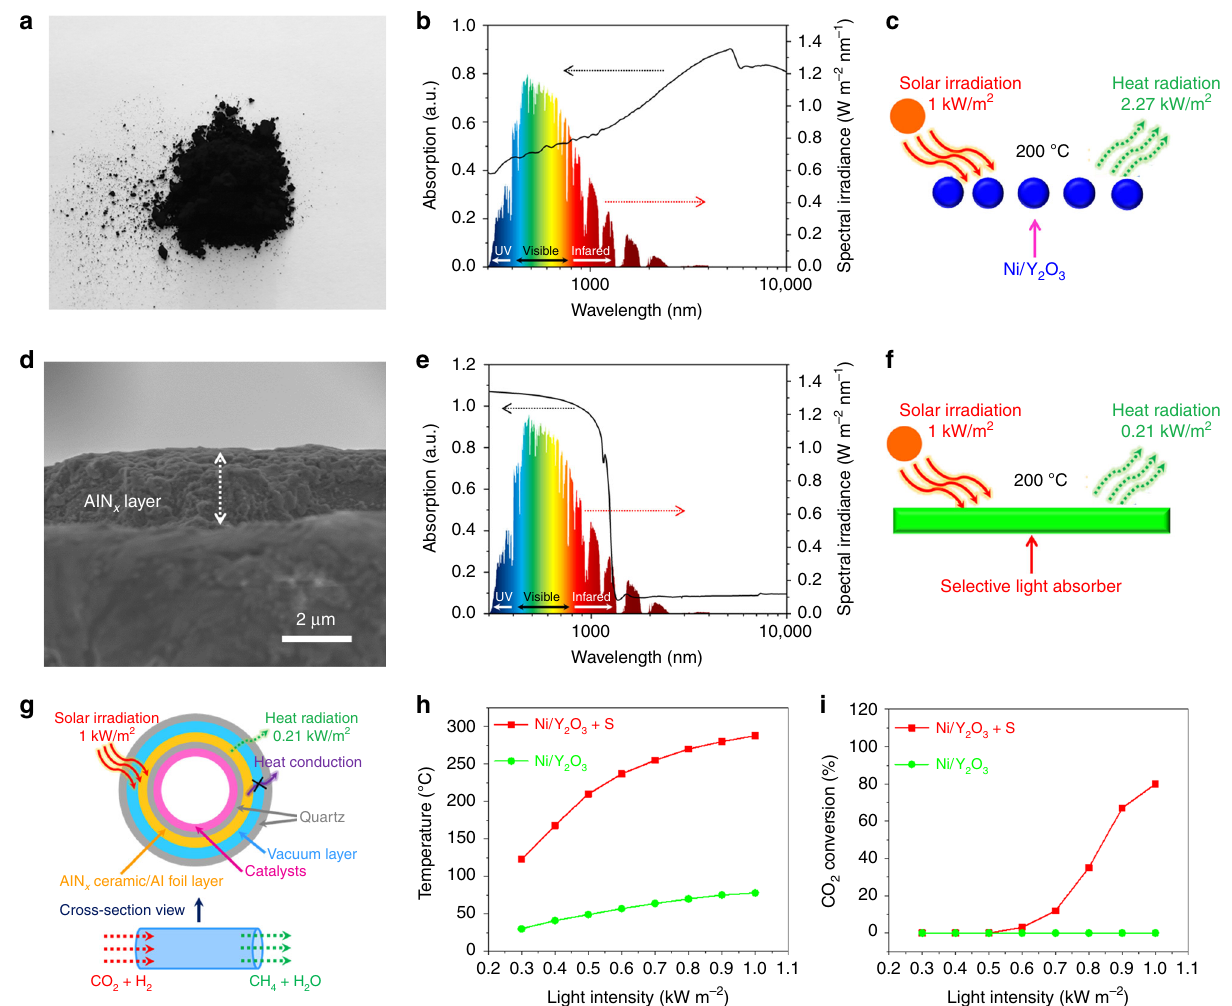
Fig. 1 Traditional and selective light absorber-assisted photothermal systems. a Photograph of the Ni/Y 2 O 3 nanosheets powder. b Normalized UV – Vis – IR absorption spectrum of the Ni/Y 2 O 3 nanosheets. c Solar energy absorption and thermal radiation diagram for the Ni/Y 2 O 3 nanosheets at 200 °C. The ambient solar fl ux of 1 kW m − 2 is not enough to sustain the thermal radiation; thus, an equilibrium temperature of 200 °C cannot be obtained. d Cross- sectional SEM image and e normalized UV – Vis – IR absorption spectrum of the selective light absorber (AlN x /Al foil). f Solar energy absorption and thermal radiation diagram of the selective light absorber at 200 °C. The thermal radiation was far below the absorbed energy from ambient solar fl ux. g Schematic of the new photothermal system used for photothermal CO 2 methanation with the selective absorber and the catalysts. h , i The light-driven temperature and CO 2 conversion rates of the Ni/Y 2 O 3 nanosheets with (Ni/Y 2 O 3 + S red) and without (Ni/Y 2 O 3 green) the selective light absorber-assisted photothermal system, respectively, under different intensities of sunlight irradiation. The scale bar in d is 2000